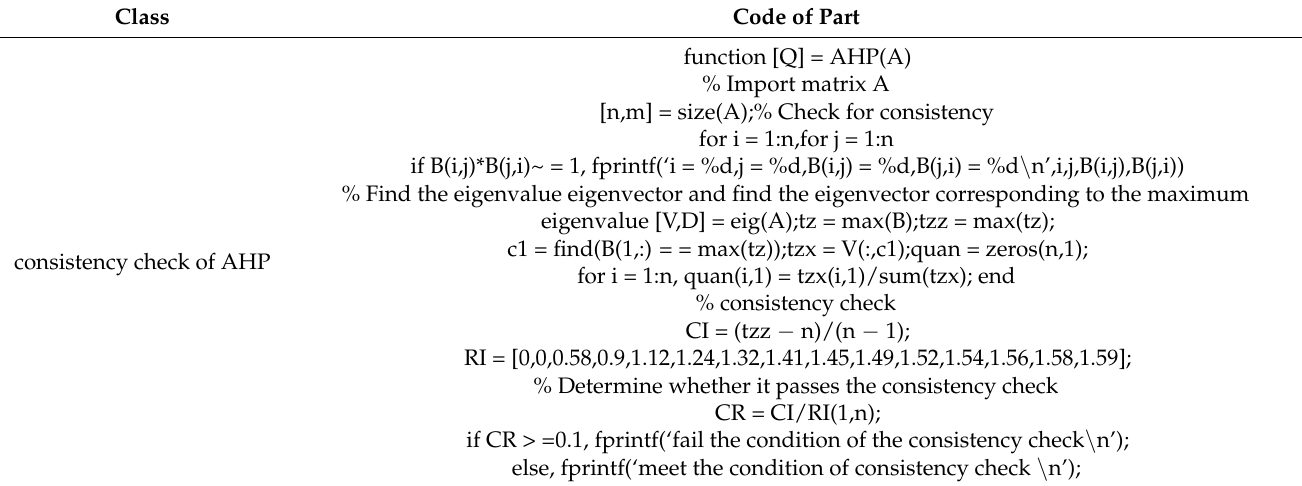
Table 6. Matlab language code.